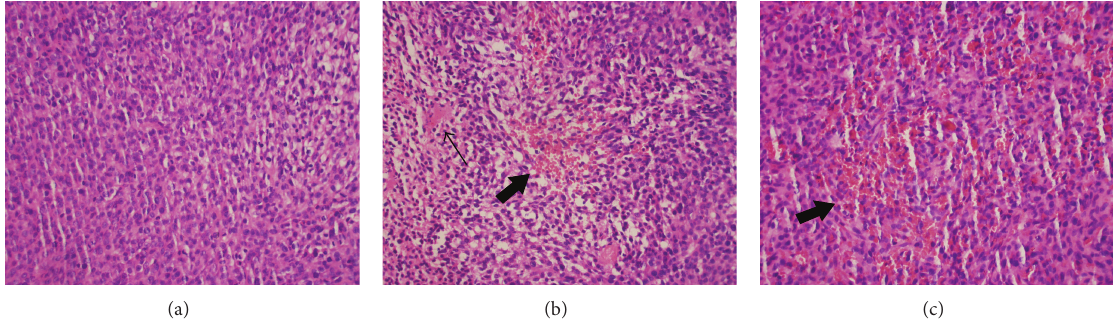
Figure 7: Hematoxylin and eosin (HE) staining of the xenograft tumor tissues from control group (a), C6-TK group (b), and C6-sr39TK group (c) at day 17 after ganciclovir (GCV) administration ( × 400). Thin arrow and broad arrow indicated necrotic or hemorrhagic areas in tumors from C6-TK group and, more prominently, the C6-sr39TK group.